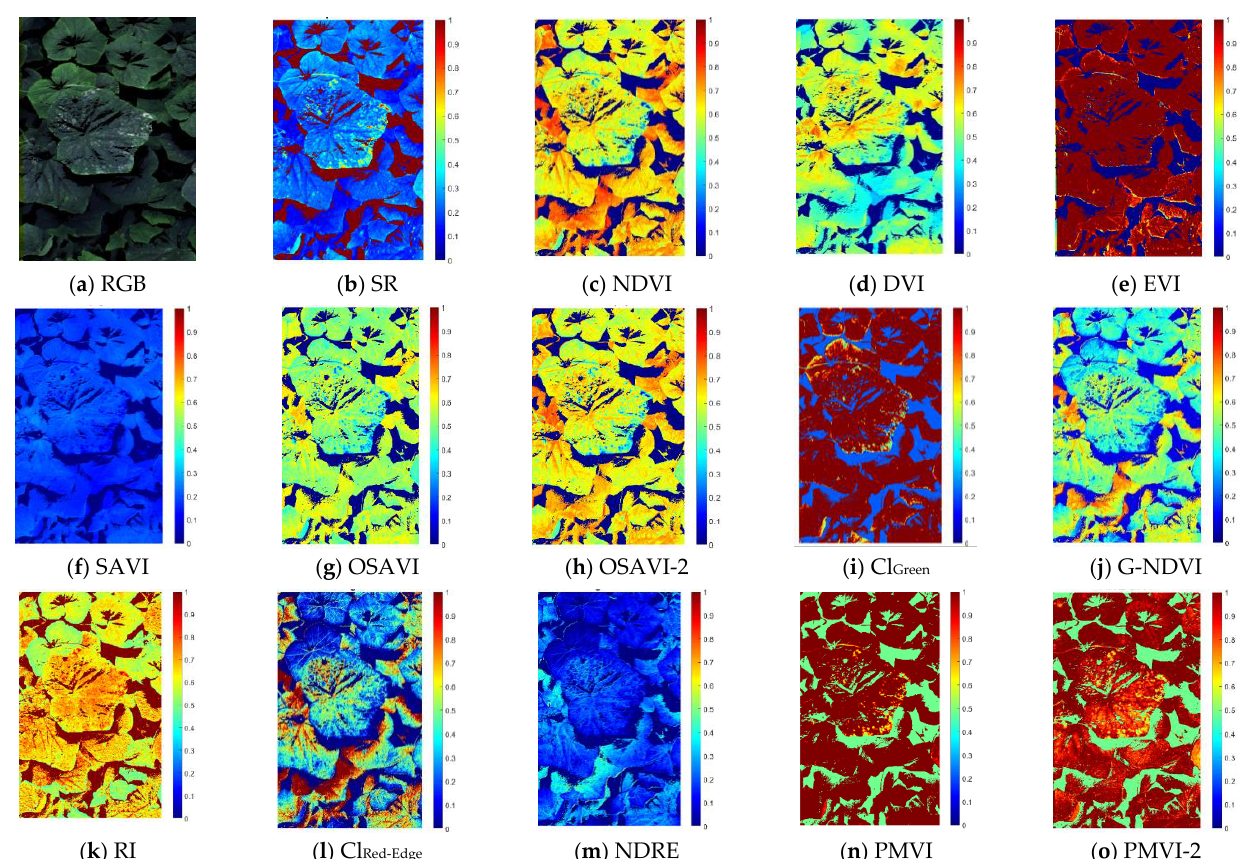
Figure 5. Comparison between ( a ) aligned and masked RGB cucumber canopy images and ( b ) the same image after ap- plying the illumination correction.